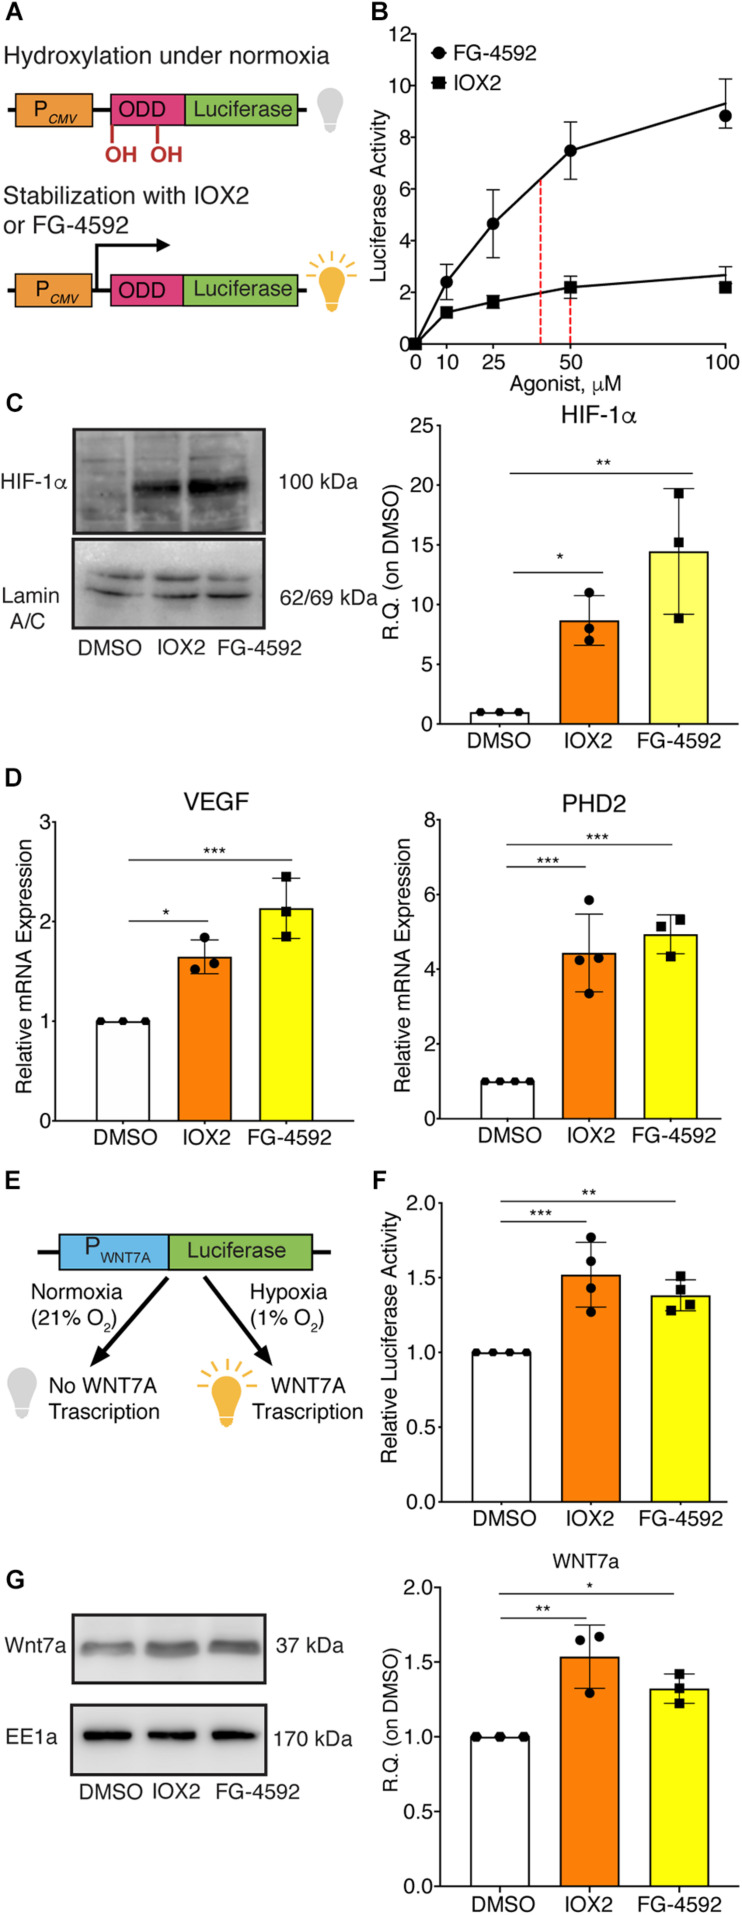
Pharmacological activation of hypoxia inducible factor-1α (HIF-1α) with prolyl-hydroxylases (PHDs) inhibitors and its effects on WNT7A regulation. (A) Schematic representation of the pcDNA3 construct containing the oxygen dependent domain (ODD)-luciferase reporter gene. Under normoxia, the proline residues on the ODD sequence are hydroxylated by the PHDs, and the complex degraded by the proteasome, eventually inhibiting the generation of the luminescence signal; the pharmacological inhibition of the PHDs causes the stabilization of the ODD, inducing the production of luminescence. (B) IC50 quantification of IOX2 or FG-4592 by luciferase assay with the ODD-pcDNA3 construct (n = 3). (C) Western blot analysis and relative quantification of HIF-1α nuclear localization in murine myoblasts treated with IOX2 or FG-4592 for 24 h. The nuclear marker Lamin A/C was used as the housekeeper (n = 3). (D) qPCR analysis of HIF-1α target genes, VEGF and PHD2, upon PHDs inhibition with IOX2 or FG-4592 (n = 3). (E) Schematic representation of pNL1.1 plasmid containing the WNT7A promoter upstream of the luciferase gene reporter under normoxia and upon IOX2 or FG-4592 treatment. (F) Quantification of pNL1.1-WNT7A promoter activity by luciferase assay of murine myoblasts treated with IOX2 or FG-4592 (n = 4). (G) Western blot analysis and relative quantification of Wnt7a accumulation in murine myoblasts treated with IOX2 or FG-4592 for 24 h. EE1a was used as the housekeeper (n = 3). Data information: all data represent mean ± SD. *p < 0.05, **p < 0.01, ***p < 0.001 (Ordinary one-way ANOVA).